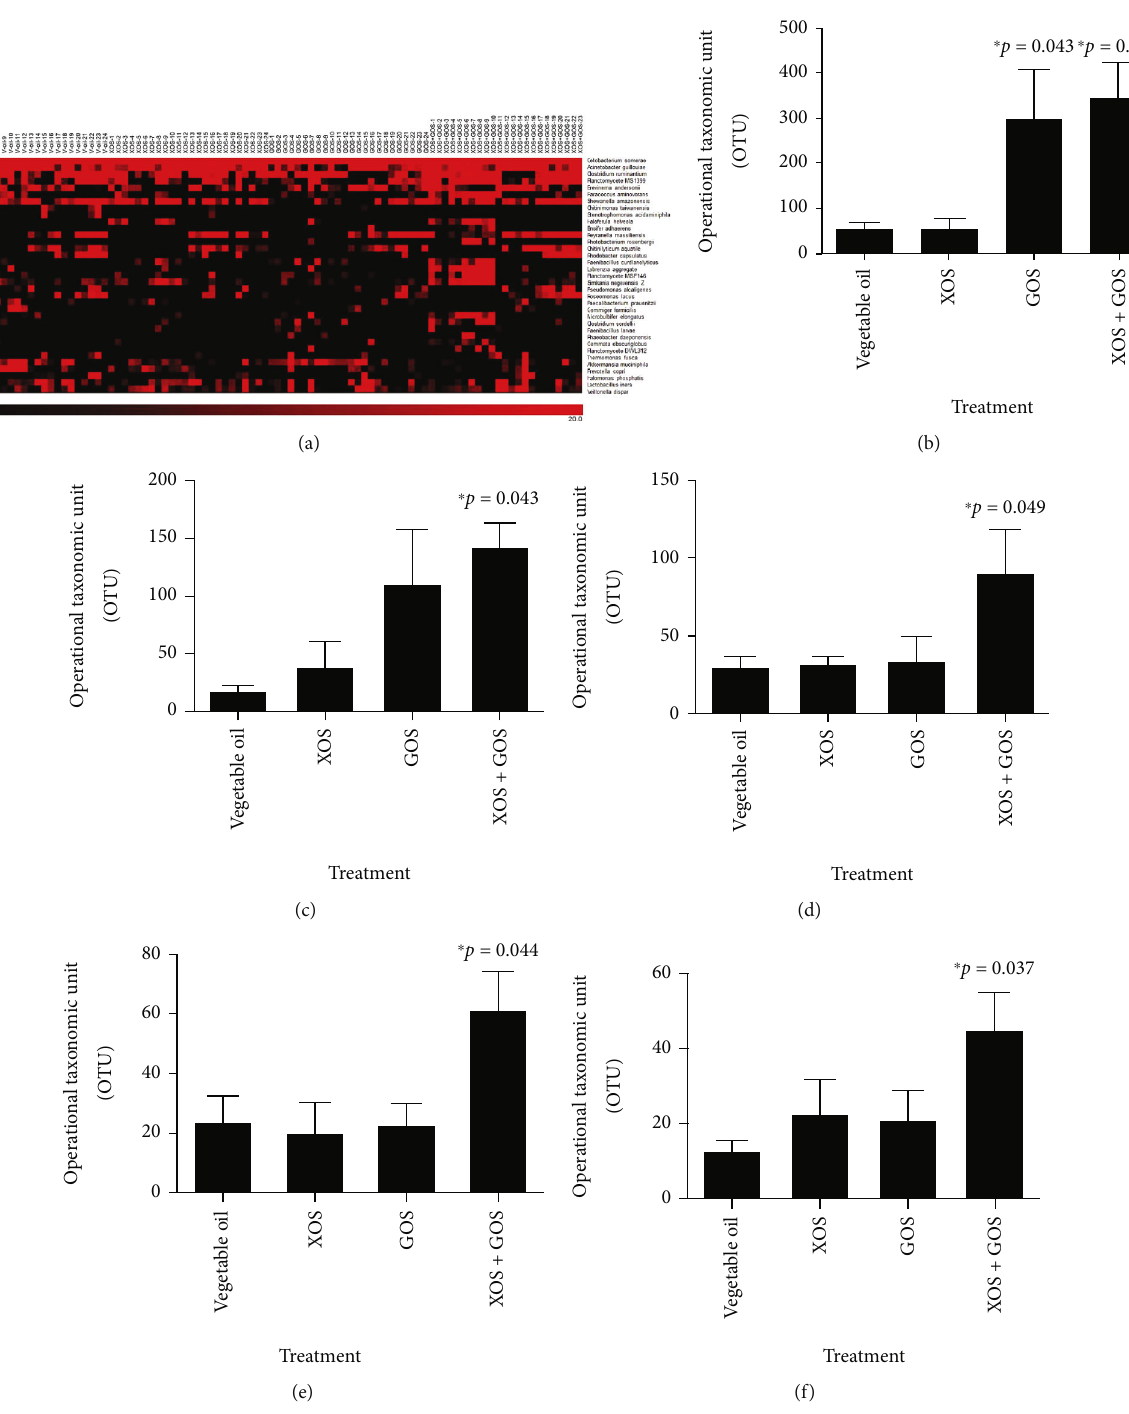
Figure 5: Bacteria species identi fi ed by 16S rDNA sequencing analysis. The identi fi ed bacteria with known species names were demonstrated by the heatmap with the color representing the species abundance (a). The bacteria species with upregulated abundance in XOS, GOS, or XOS +GOS include Clostridium ruminantium (b), Brevinema andersonii (c), Shewanella amazonensis (d), Reyranella massiliensis (e), and Chitinilyticum aquatile (f). ∗ 0 : 01 < p < 0 : 05 ; n = 24